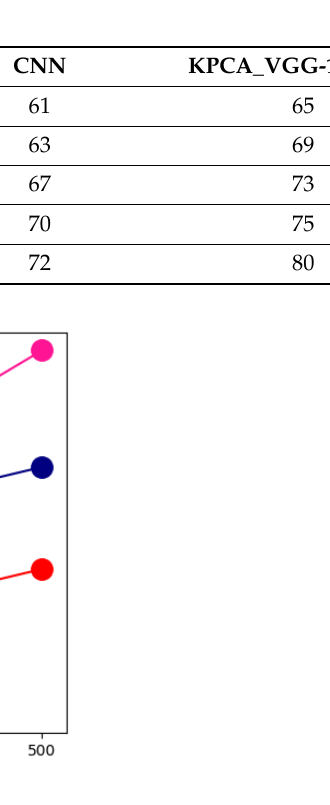
Figure 5. Comparison of Recall.